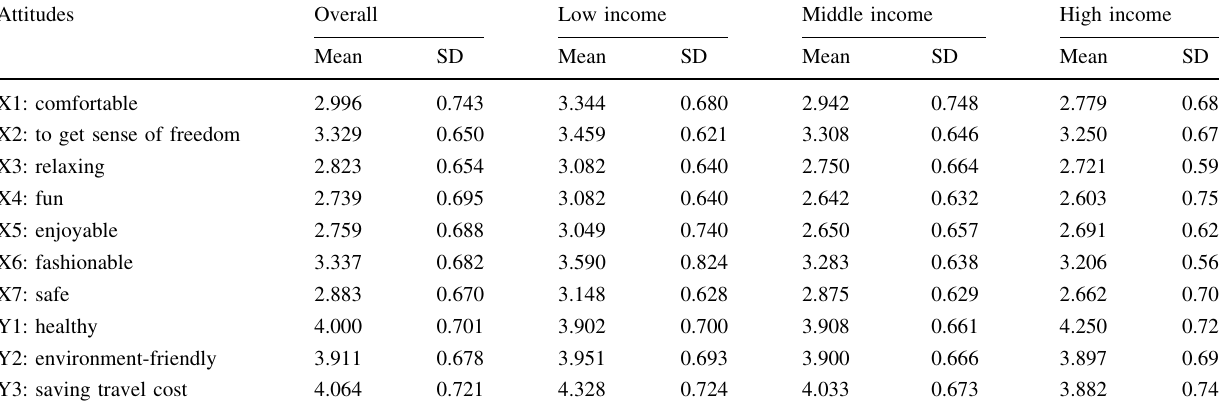
Table 3 Average score of attitudes toward walking to transit station in each income group Attitudes